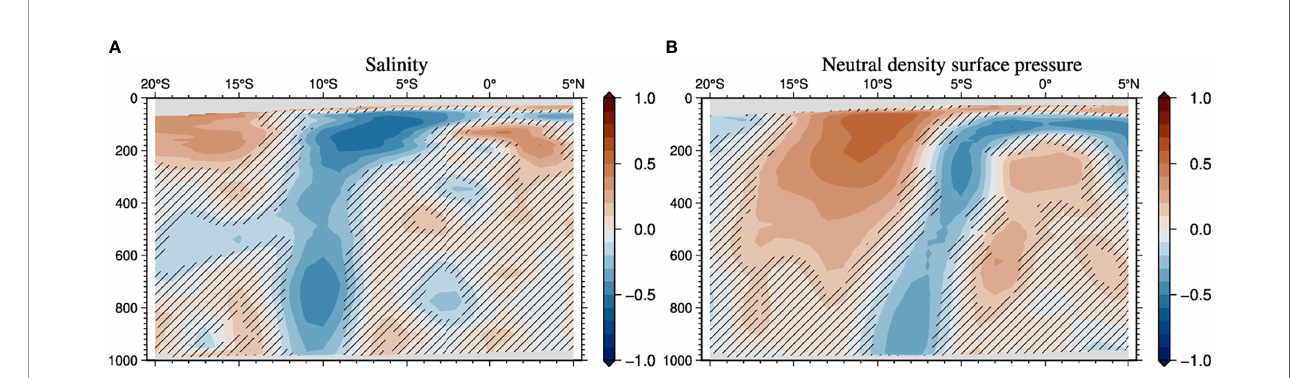
FIGURE 10 | Four-month-lag correlations of salinity (A) and isopycnal depths (B) with DMI ( Figure 7 ) in the vertical section along 80°E based on the Argo gridded dataset. The non-hatched areas corresponded to areas of high signi fi cance (p-value < 0.1).